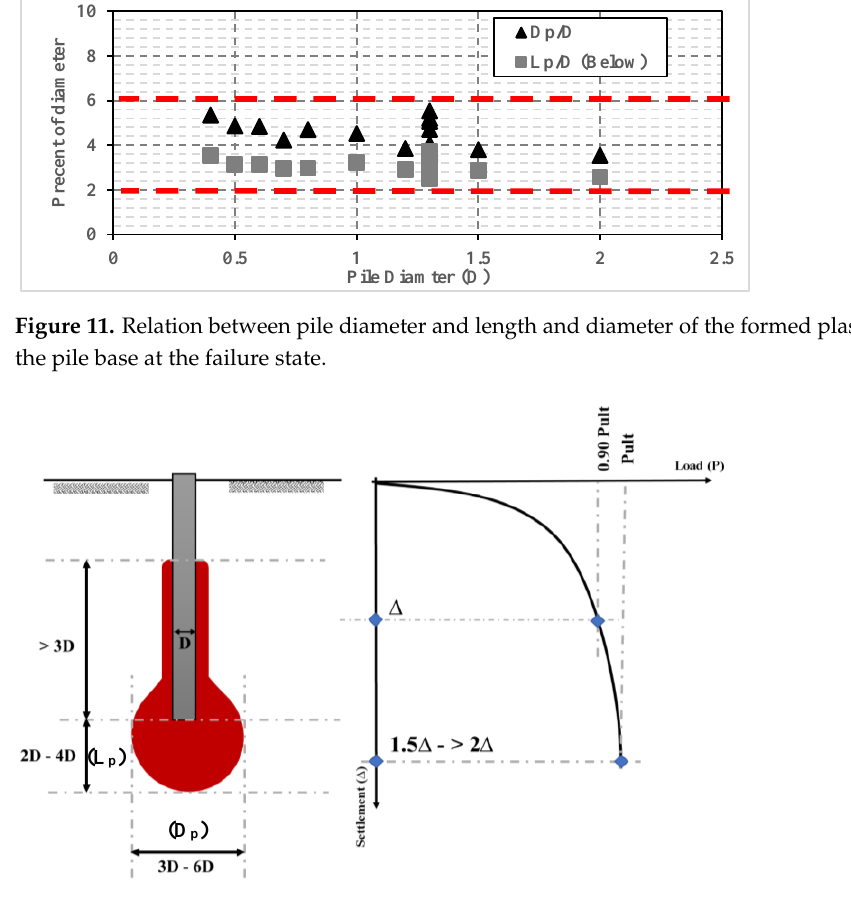
Figure 12. Schematic diagram showing the formed plastic bulb’s predicted size and the induced settlement at the failure state of large diameter bored piles.